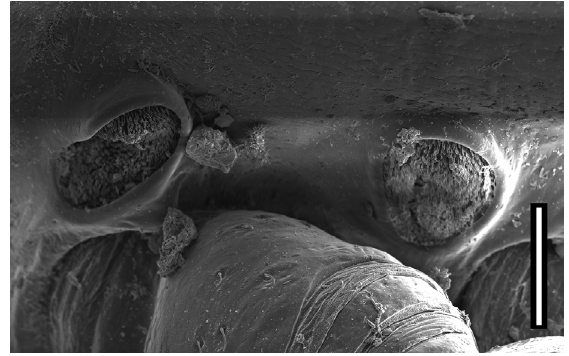
Fig. 11. Pogonosternum nigrovirgatum (Carl, 1902), male, spiracles, midbody ring, left lateral view (NMV K-12158). Scale bar: 0.1